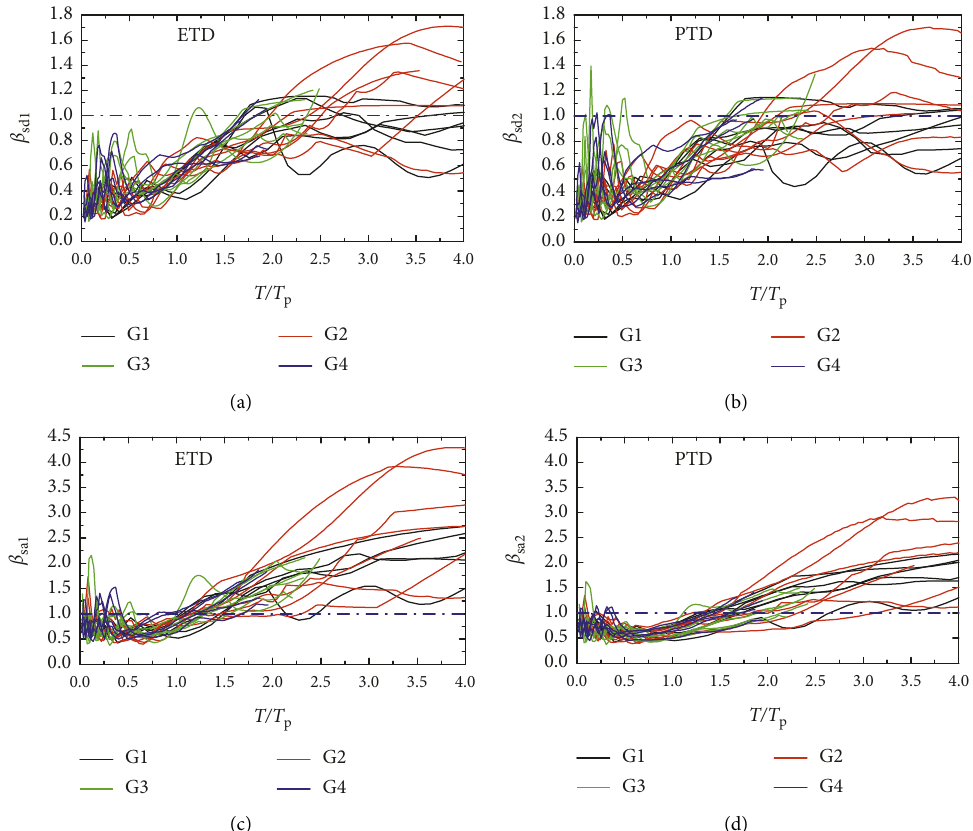
Figure 7: Normalized displacement and acceleration spectra for ETD and PTD ( R � 4): (a)-(b) normalized displacement spectra for ETD and PTD, respectively; (c)-(d) normalized acceleration spectra for ETD and PTD,